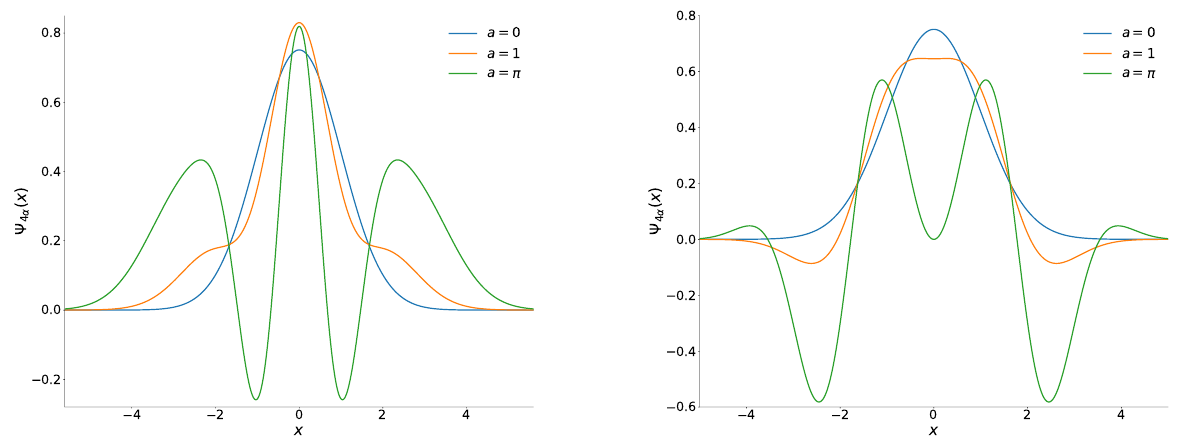
√ a exp ( i φ ) . Left : φ = 0. Right : φ = π